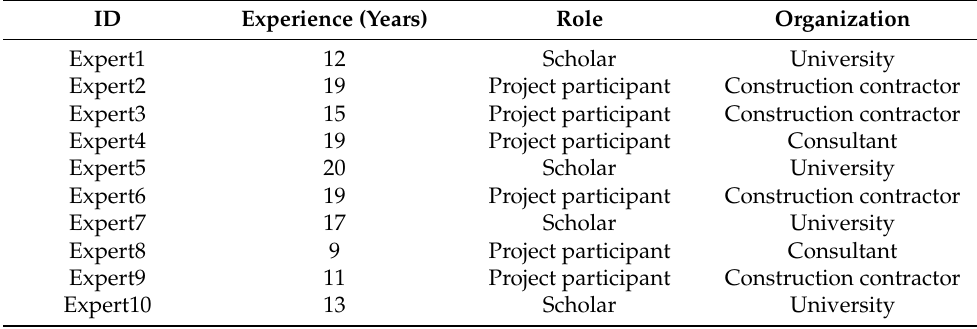
Table 1. The information of interviewed